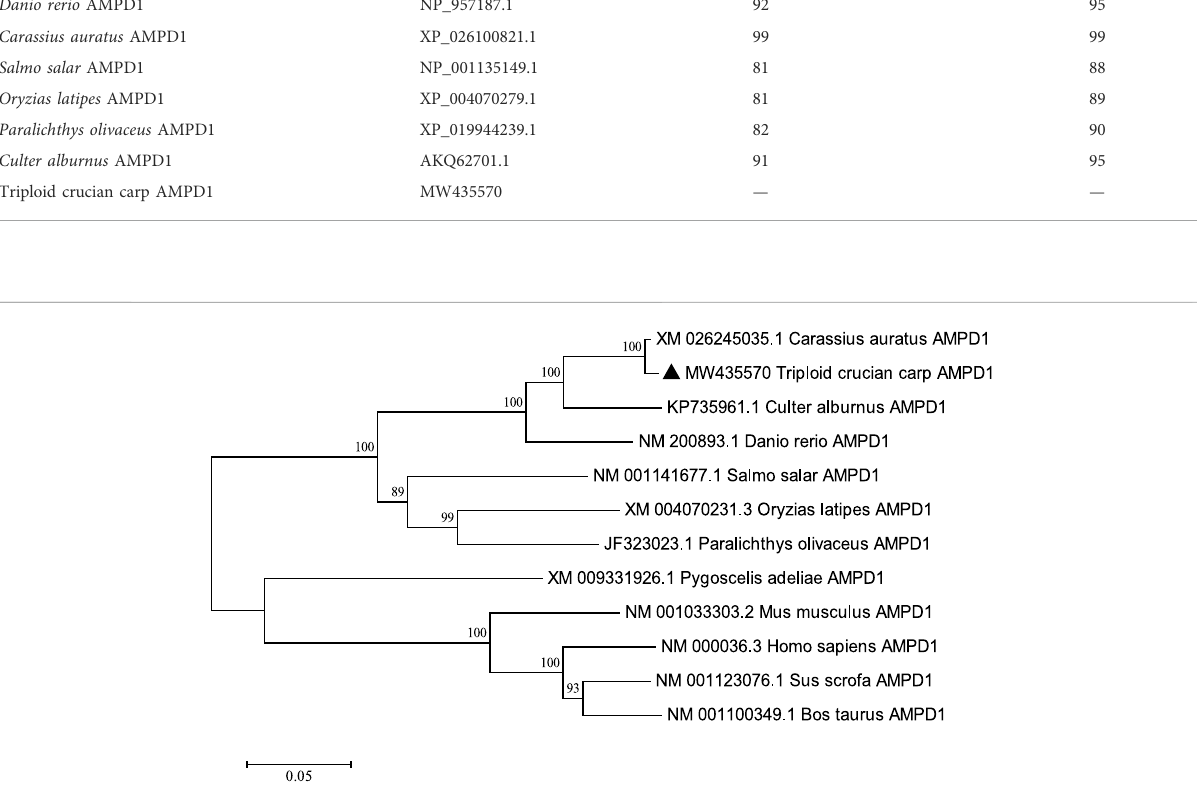
FIGURE 2 Adjacency phylogenetic tree based on AMPD1 amino acid sequences of different species. Node values represent the percent bootstrap con fi dence level derived from 1000 replicates. The bar (0.05) indicates the genetic